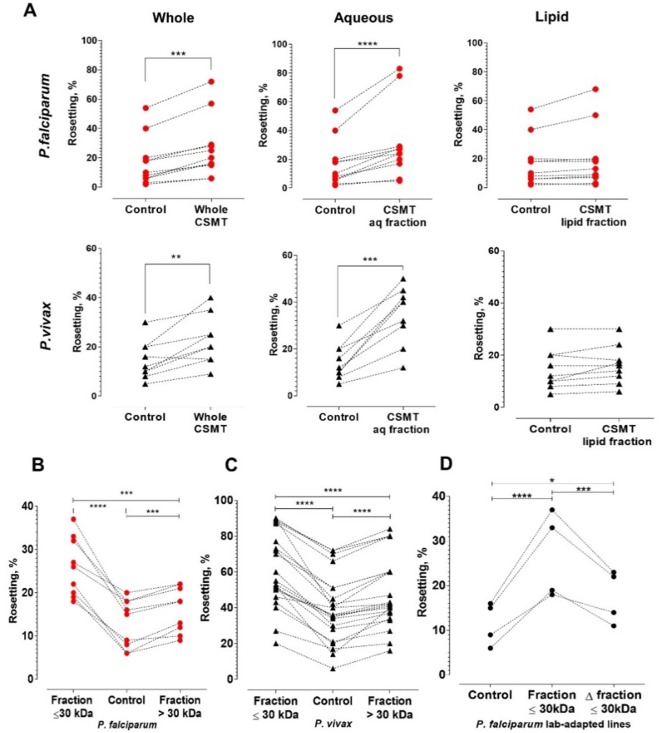
Characterization of the secreted rosette-stimulating factors.(A) Rosetting of clinical isolates (Pf: n = 11, Pv: n = 9) post-incubation with whole CSMT (paired t-test Pf: p=0.0001; Pv: p=0.0017) and its aqueous (Pf: p<0.0001; Pv: p=0.0002) and lipid (Pf: p=0.0954; Pv: p=0.0905) fractions. (B, C) Pf (n = 9) and Pv (n = 22) rosetting post-incubation with CMST aqueous fractions of different sizes. From one-way ANOVA with Tukey’s test, both smaller-size (Pf: p<0.0001; Pv: p<0.0001) and larger-size (Pf: p=0.0007; Pv: p<0.0001) fractions significantly stimulated rosetting, with the smaller-size fraction exerting higher rosette-stimulation than the larger-size fraction (Pf: p=0.0005; Pv: p<0.0001). (D) Effect of heating on rosette-stimulation by the CMST aqueous ≤30 kDa fraction. The experiment was conducted with laboratory-adapted P. falciparum (n = 4). One-way ANOVA with Tukey’s test: the unheated (p<0.0001) and heat-denatured (Δ) fractions (p=0.0236) stimulated rosetting, with the unheated fraction exerting higher stimulation than the heated fraction (p=0.0009). *p<0.05, **p<0.01, ***p<0.001, ****p<0.0001.